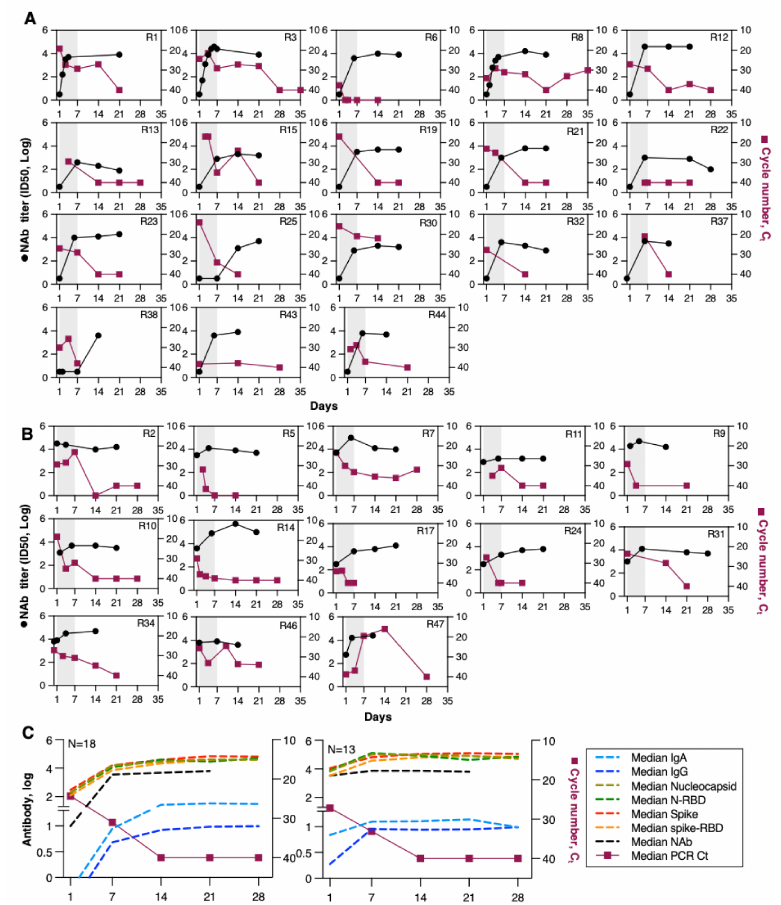
Figure 3. Kinetics of Neutralizing antibody (NAb) and viral load (Ct). NAb and viral loads (Ct values) of patients ( n = 31) are shown separated as in Figure 1. ( A ) Patients ( n = 18) with undetectable pseudotype NAb antibodies. ( B ) Patients ( n = 13) with a median reciprocal pseudotype NAb titer (ID50) of 3.5 log at day 1. ( C ) Median values of reciprocal endpoint titers are shown for Nucleocapsid, N-RBD, Spike, Spike-RBD (from Figure 1), and pseudotype NAb (from panels ( A , B )) indicated on the left axis, and the Ct values are indicated on the right axis. Grey shaded area marks the time of the 3 convalescent plasma transfusions. The median Spike-specific IgA and IgG reported previously [20] are also superimposed, showing similar